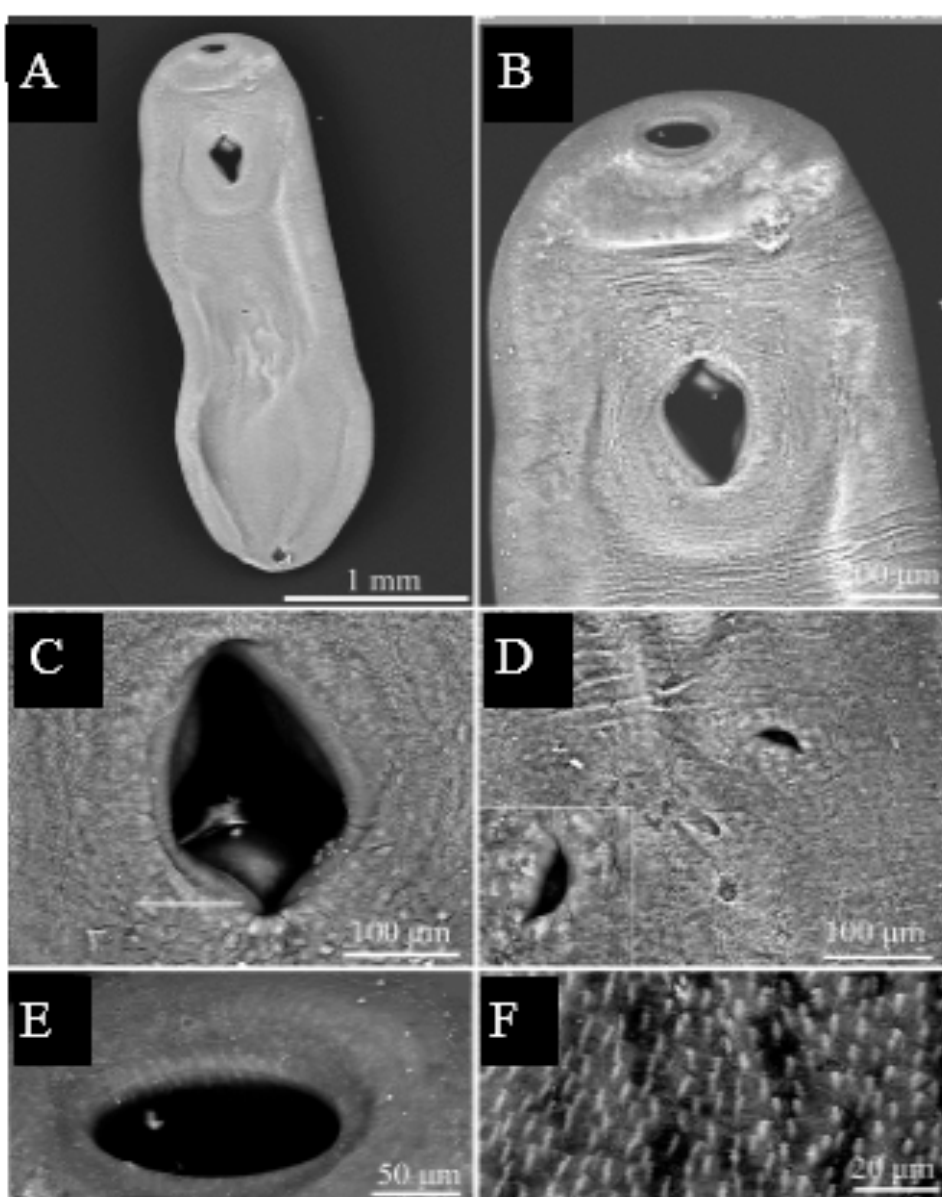
F IGURE 4. Scanning electron micrographs of the metacercariae of Clinostomum complanatum , A. Whole worm, B. enlarged view of ventral and oral suckers, C. enlarged view of ventral sucker, D. genital pore, E. oral sucker, F. cuticular spines on body